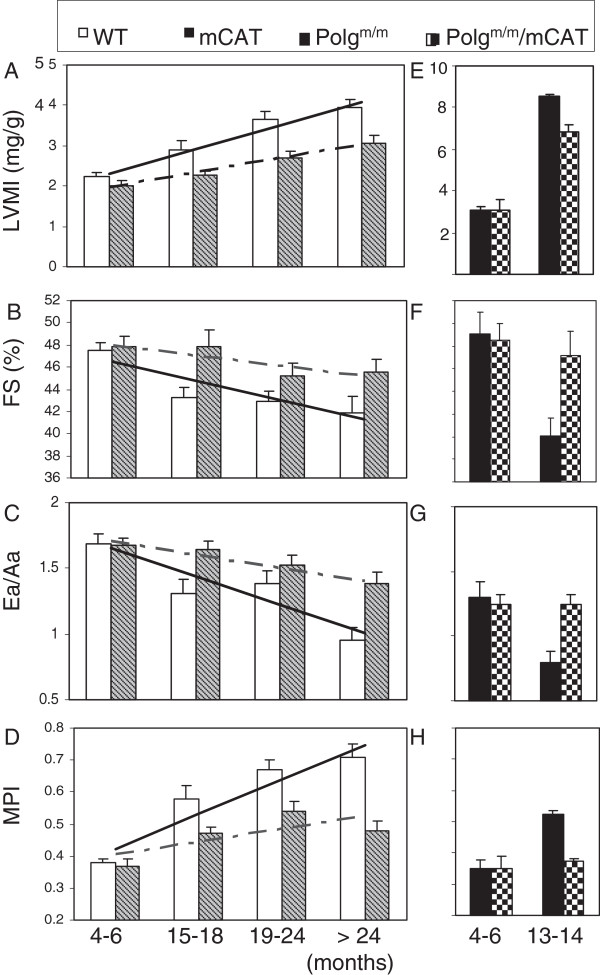
Echocardiography of cardiac aging in wild-type (WT) and mCAT mice (A-D) and Polgm/m mice in the presence or absence of mCAT (E-H). (A, E) Left ventricular mass index (LVMI), (B, F) % FS (fractional shortening), (C, G) Ea/Aa by tissue Doppler imaging (diastolic function), (D, H) the myocardial performance index (MPI). The increased linear trends across ages in WT mice were significant for all parameters (P <0.05 for all, left panels). The beneficial effect of mCAT versus WT was analyzed by the interaction between genotype and the linear age trend, and was significant in all cases (P <0.01 for all except fractional shortening, P = 0.03). *P <0.05 versus Polgm/m at age 4 to 6 months, #P <0.05 versus Polgm/m at age 13 to 14 months (right panels). LVMI, Left ventricular mass index; mCAT, catalase targeted to mitochondria. Modified from Dai et al. [25,43].